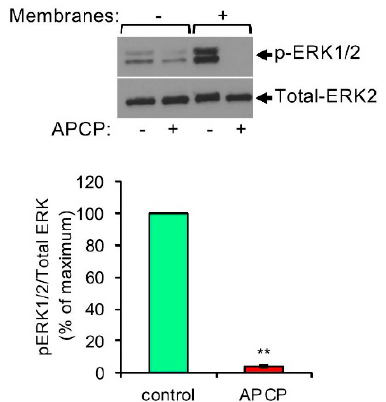
Figure 2. Pancreatic cancer cell derived membranes stimulate ERK1/2 phosphorylation in MCs by a CD73-dependent mechanism. LAD2 cells (1 × 10 6 cells/mL) were incubated for 30 min in the absence or presence of APCP (5 μ M). Cells were then left untreated or treated for 1 min with membranes derived from Mia PaCa-2 pancreatic cancer cells (50 μ g/mL), as indicated. Cell lysates were resolved by SDS-PAGE and immunoblotted with anti phospho-ERK1/2 antibodies, followed by reprobing with anti-total-ERK2 as indicated. A representative blot is shown. The intensities of the bands corresponding to phospho-ERK1/2 and total-ERK2 were quantified by densitometry using Image-J software and the relative pixel densities (phosphorylated/total) were calculated. Data are presented as mean ± SEM of three independent experiments. ** p = 2.0 × 10 − 7 . “Reprinted from Cancer Letters, 397, Yaara Gorzalczany, Eyal Akiva, Ofir Klein, Ofer Merimsky and Ronit Sagi-Eisenberg, Mast cells are directly activated by contact with cancer cells by a mechanism involving the autocrine formation of adenosine and autocrine/paracrine signaling of the adenosine A3 receptor. 23-32, Copyright © 2017 with permission from Elsevier.”